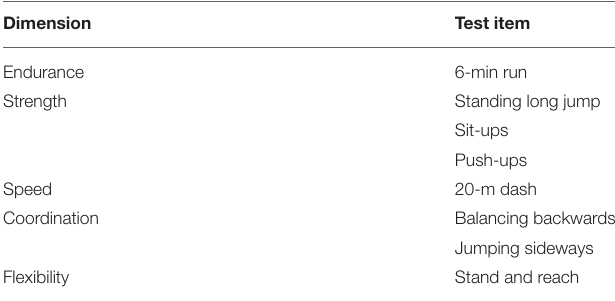
TABLE 1 | Test items of the GMT 6–18 and KITT + 3–10.